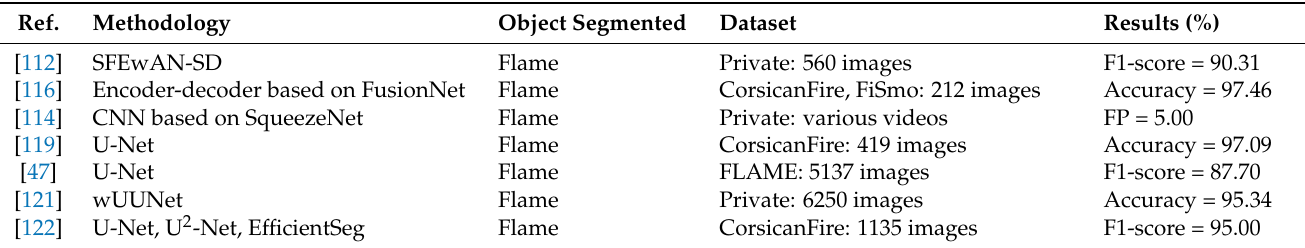
Table 3. Deep learning based wildland fire segmentation